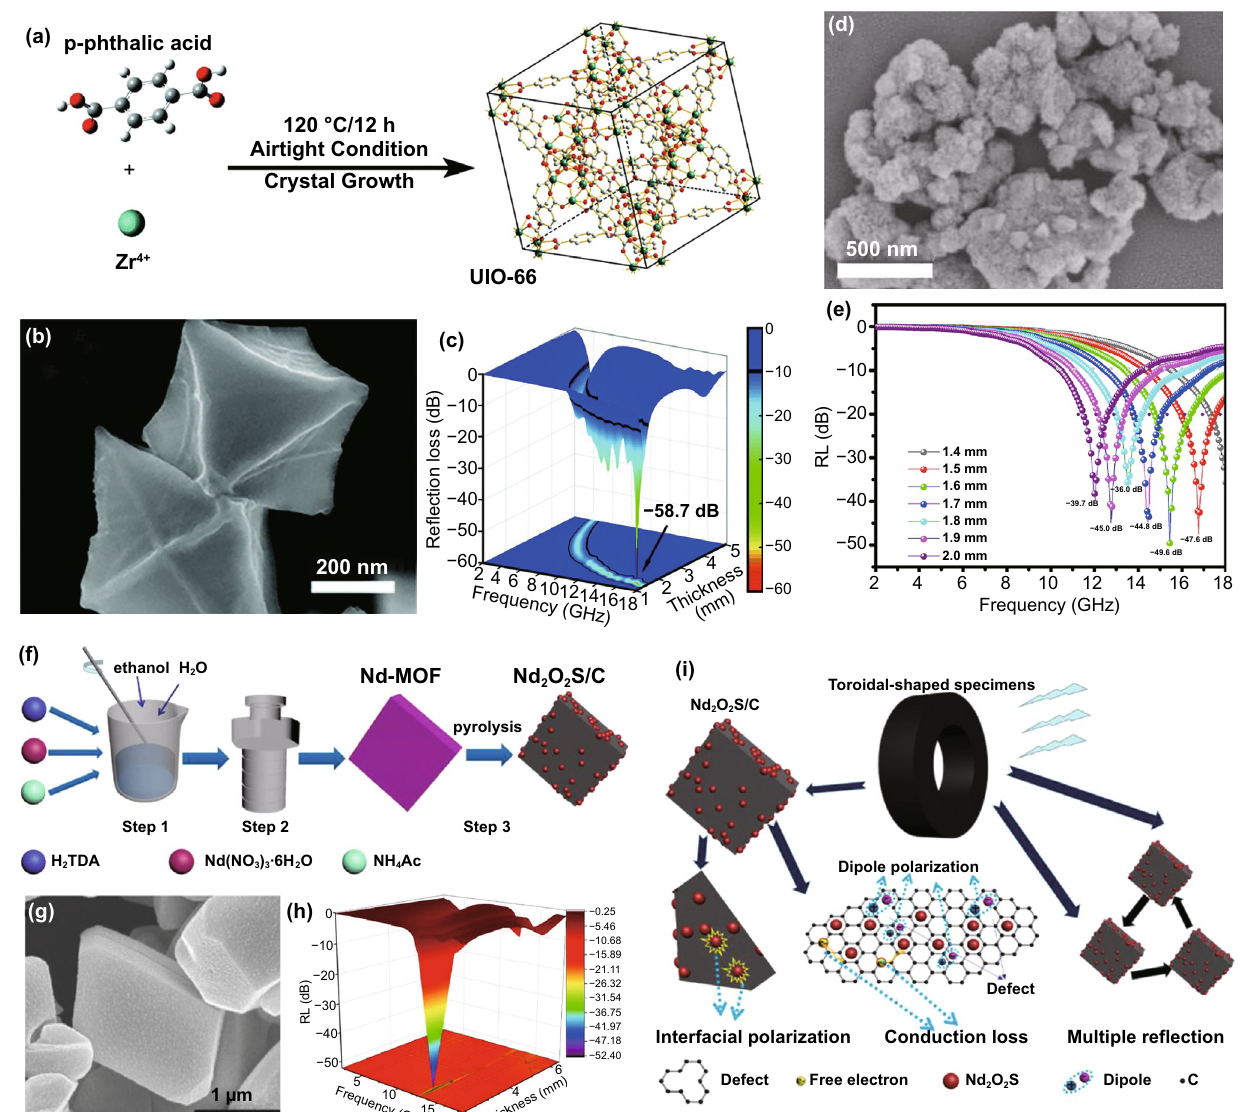
Fig. 7 a Schematic illustration of diagram and crystal structure of UIO-66. b TEM image and c 3D RL-f curves of ZrO 2 /C. Reprinted with permission from Ref. [91]. d TEM image and e RL-f curves of TiO 2 /C. Reprinted with permission from Ref. [90]. f Diagrammatic sketch of the preparation process, g SEM image, h 3D RL-f curves and i the MA mechanism of Nd 2 O 2 S/C. Reprinted with permission from Ref.